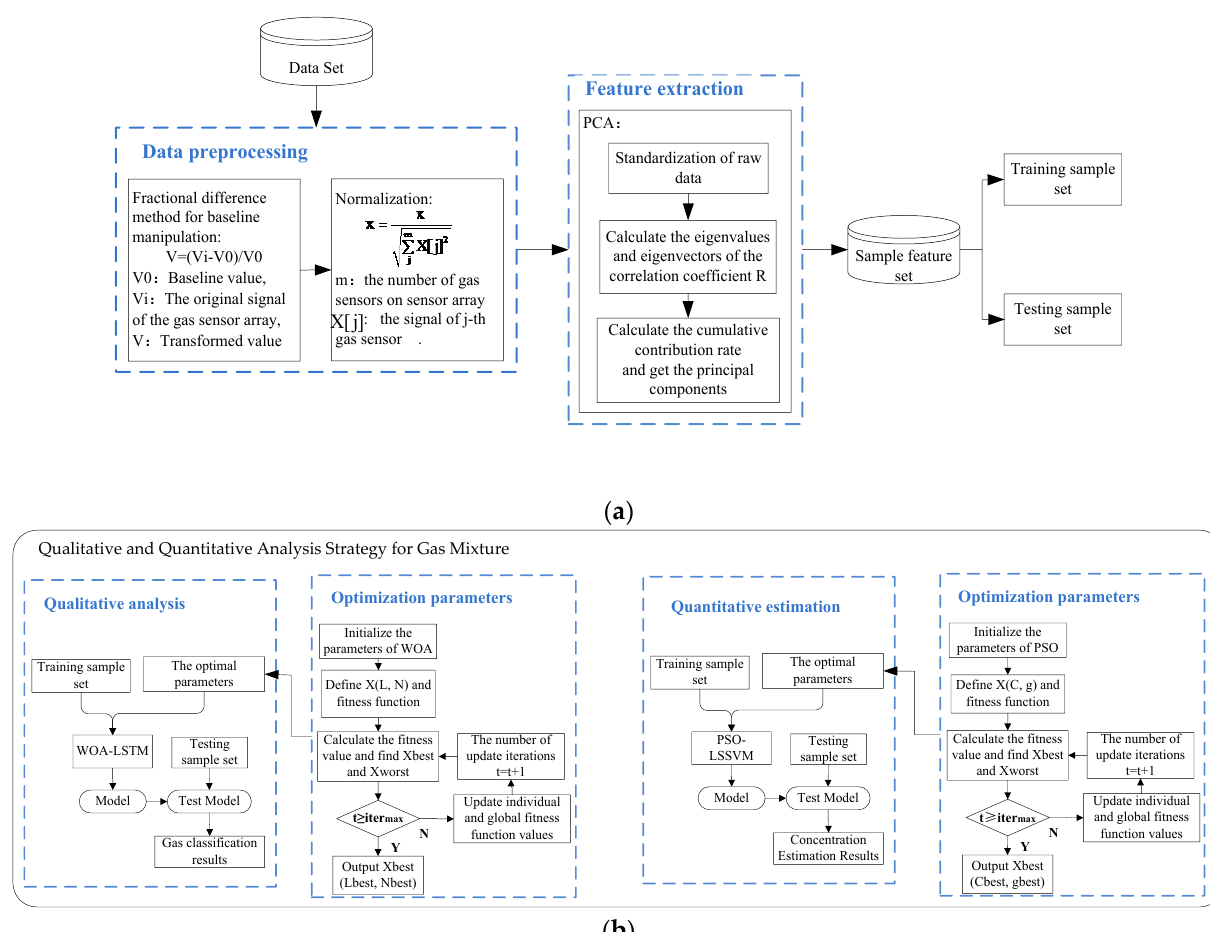
Figure 4. Flow chart of the proposed qualitative and quantitative analysis strategy. ( a ) The data preprocessing and feature extraction performed to create the sample feature set. ( b ) The modeling process of the WOA-LSTM model and PSO-LSSVM model.